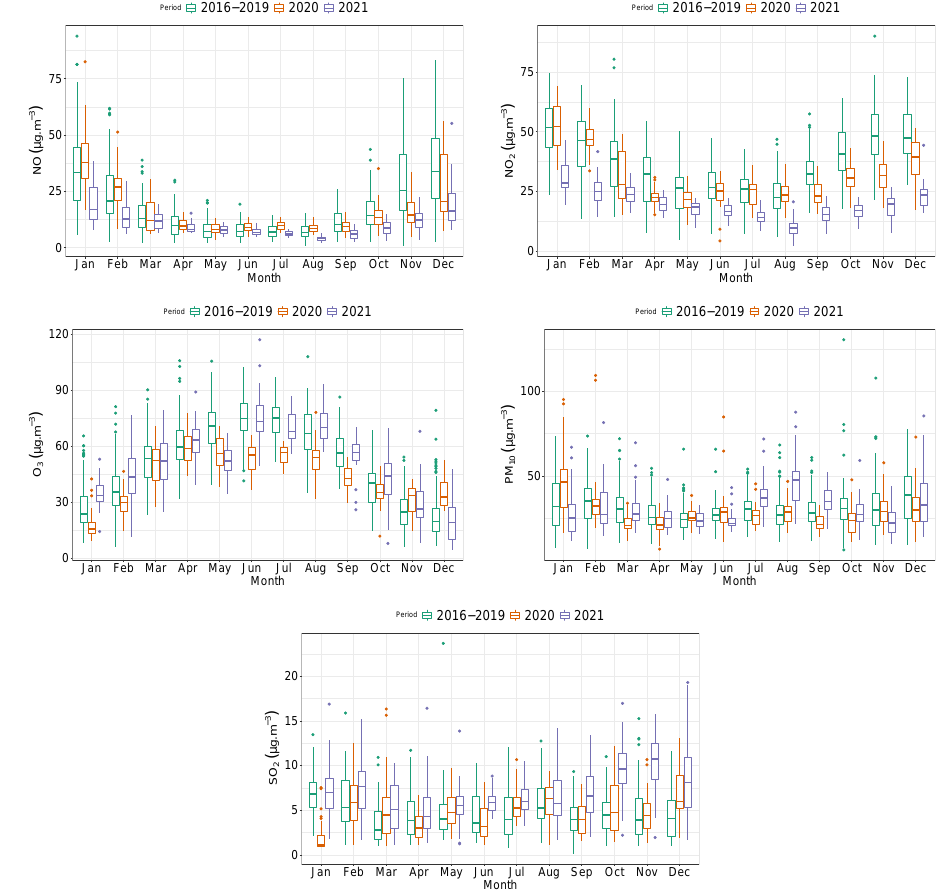
Figure 6. Box and whiskers plots of the daily concentrations of NO, NO 2 , O 3 , PM 10 , and SO 2 at the San Basilio station. The bottom and top of the box represent the first and the third quartiles, respectively; the horizontal line in the box represents the median; dots are the outliers; whiskers are the lowest and highest values, excluding the